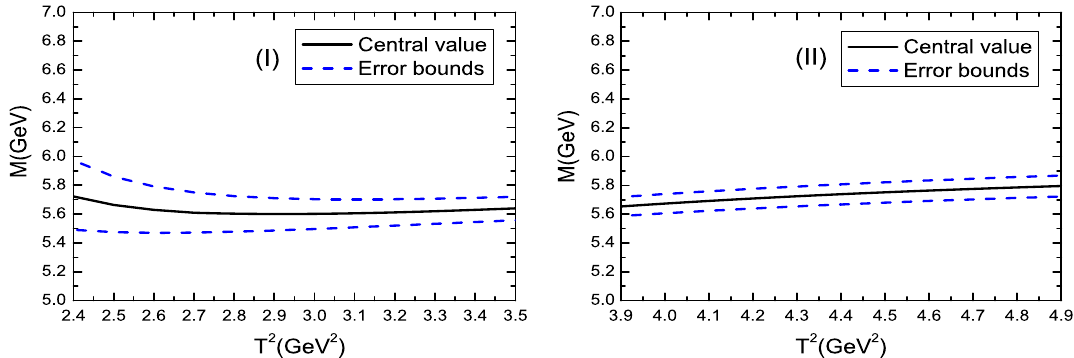
Fig. 2 The masses of the triply-charmed pentaquark states with variations of the Borel parameters, where the (I) and (II) denote the negative parity and positive parity pentaquark states, respectively